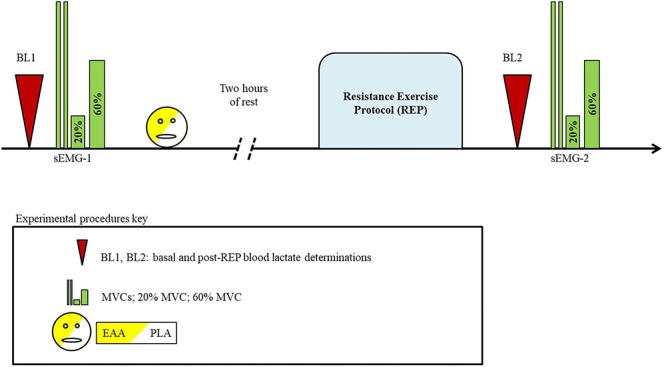
Schematic illustration of experimental procedures.